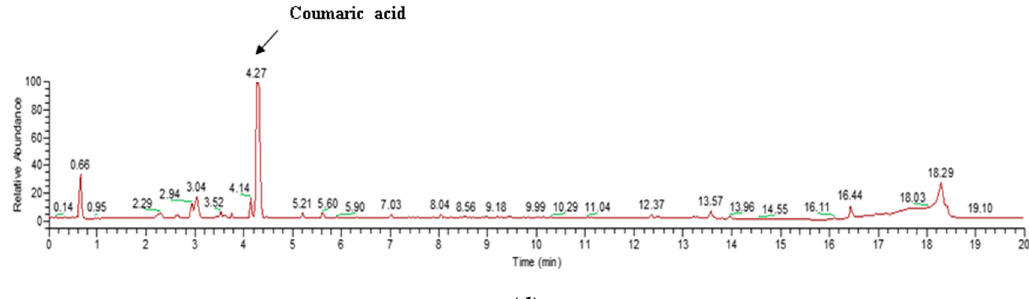
Figure 1. The effect of Pm-ME on the viability of HaCaT, B16F10, and HDF cells, with Pm-ME UPLC profiling. ( a – c ) The viabilities of Pm-ME (12.5 to 200 µg/mL)–treated HaCaT, B16F10, and HDF cells were measured via MTT assay. ( d ) The chemical profile of Pm-ME was analyzed using UHPLC and mass spectrometry. The major compound at 4.27 min was revealed to be coumaric acid.